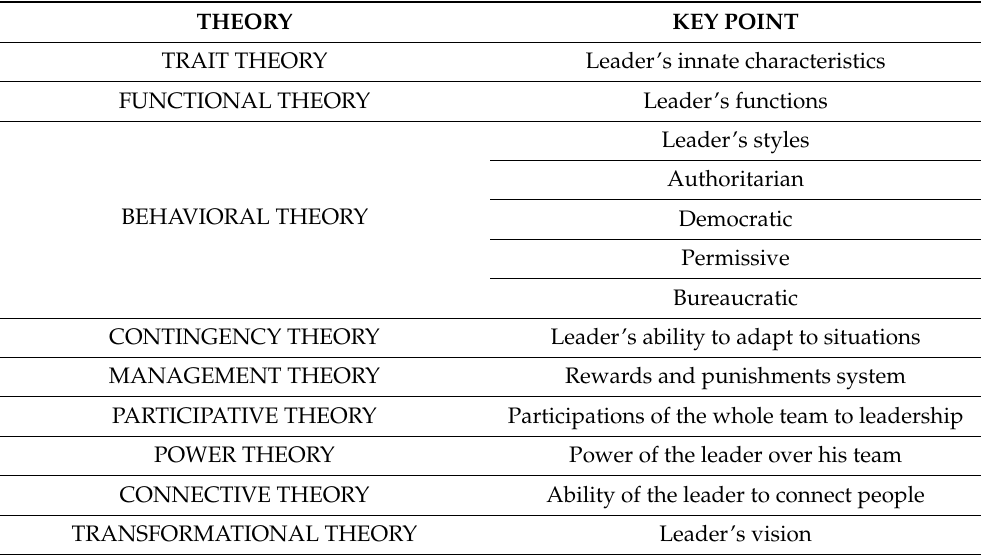
Table 1. Leadership theories and their key